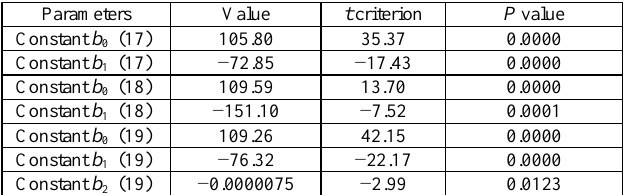
R ESULTS OF THE S TATISTICAL E VALUATION